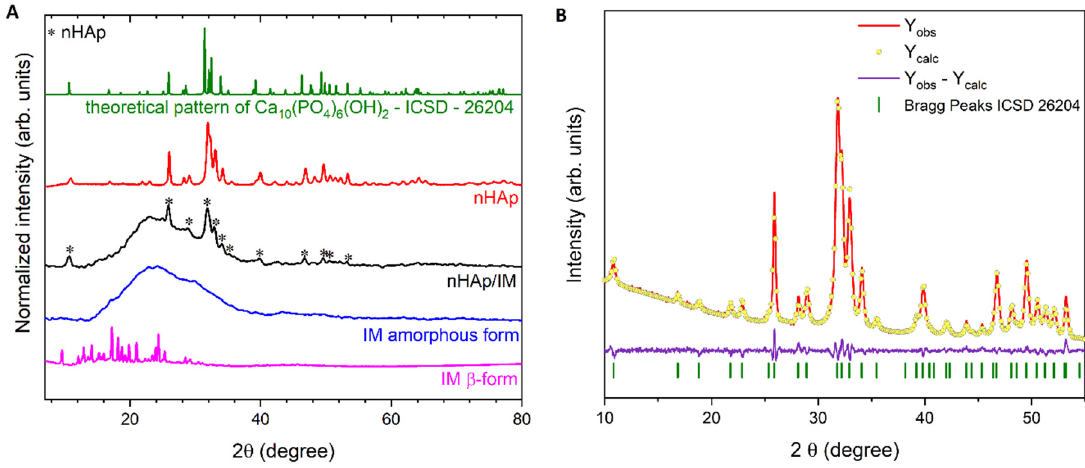
Figure 1. X-ray Powder Di ff raction (XRPD) patterns ( A ) of the crystalline imatinib (IM) β -form (magenta line), amorphous IM (blue line), nHAp modified by imatinib (nHAp / IM, black line), and nHAp (red line) with the corresponding reference hydroxyapatite pattern (ICSD–26204). Rietveld analysis ( B ) of the obtained nanohydroxyapatite (nHAp).